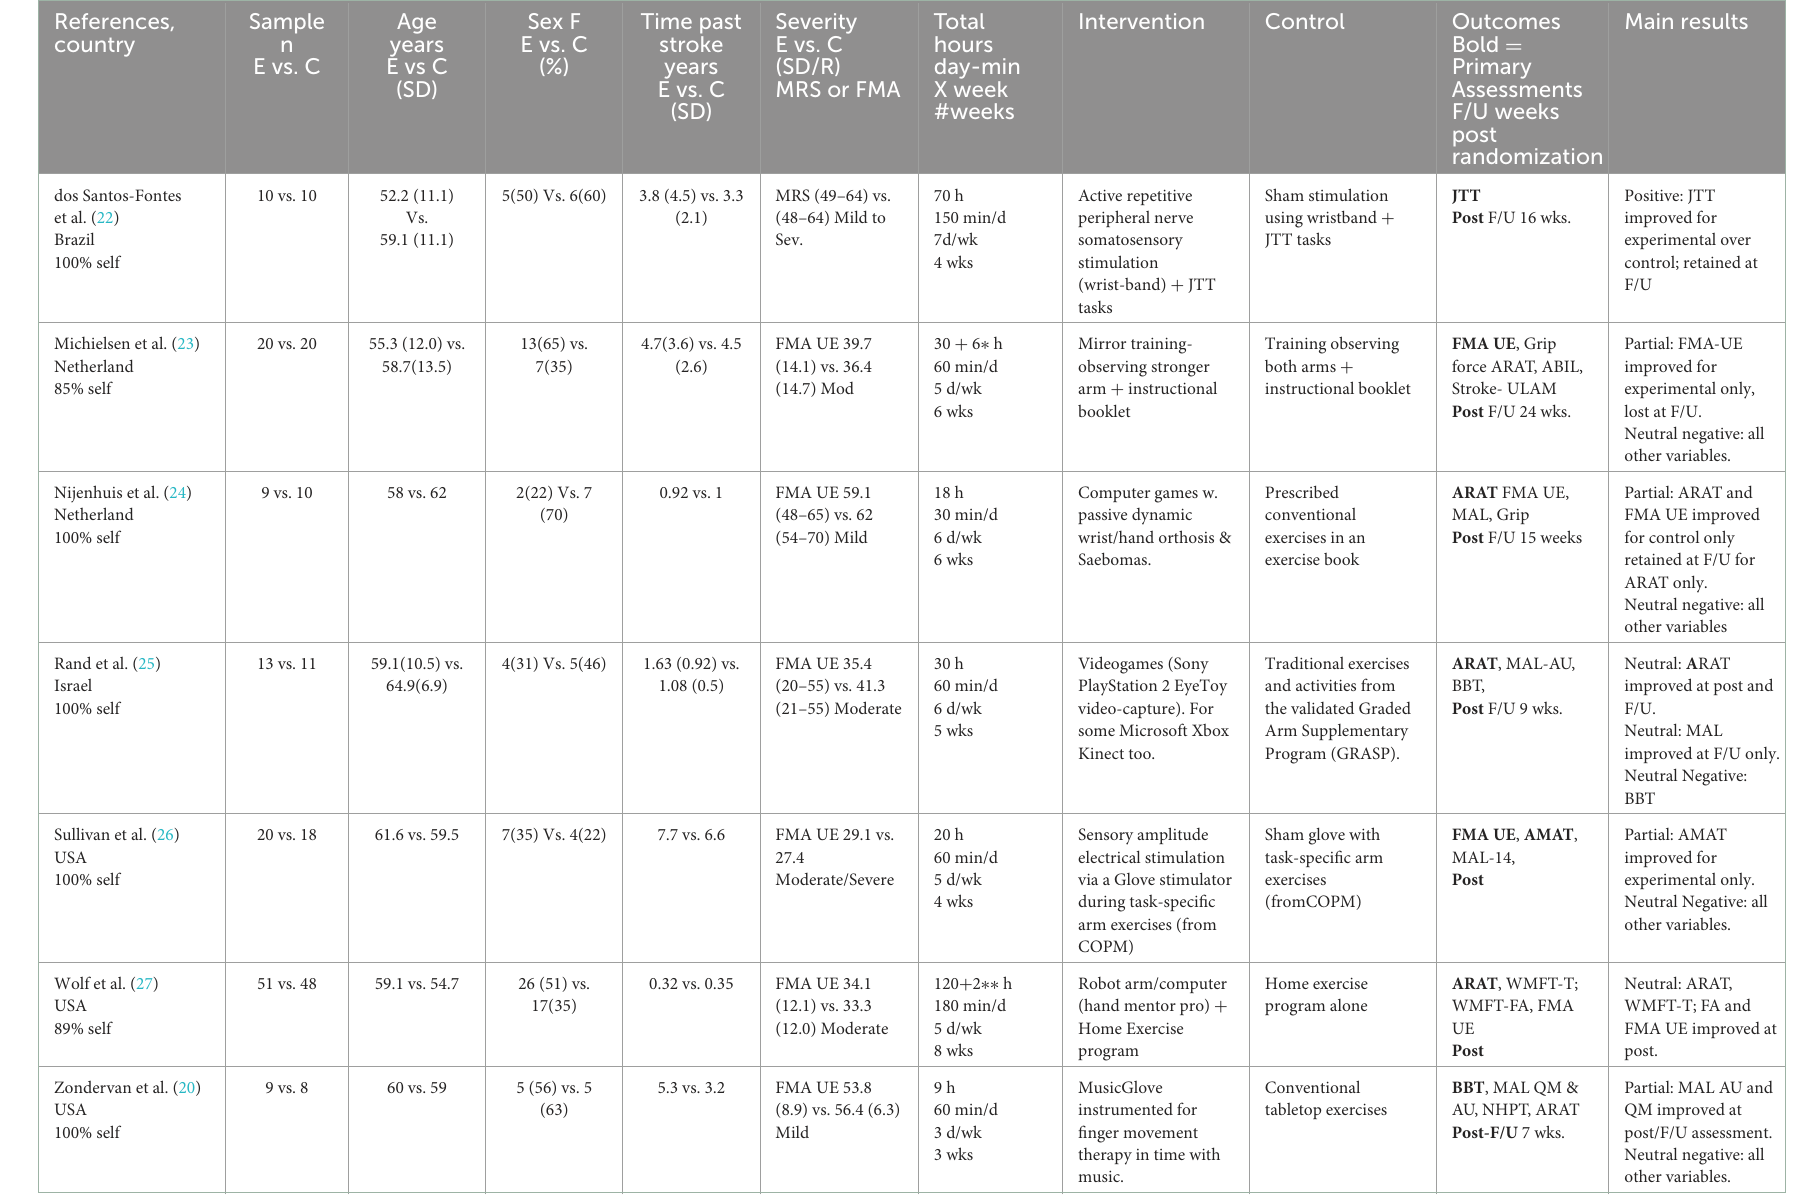
TABLE 1 Characteristics of randomized controlled trials of included